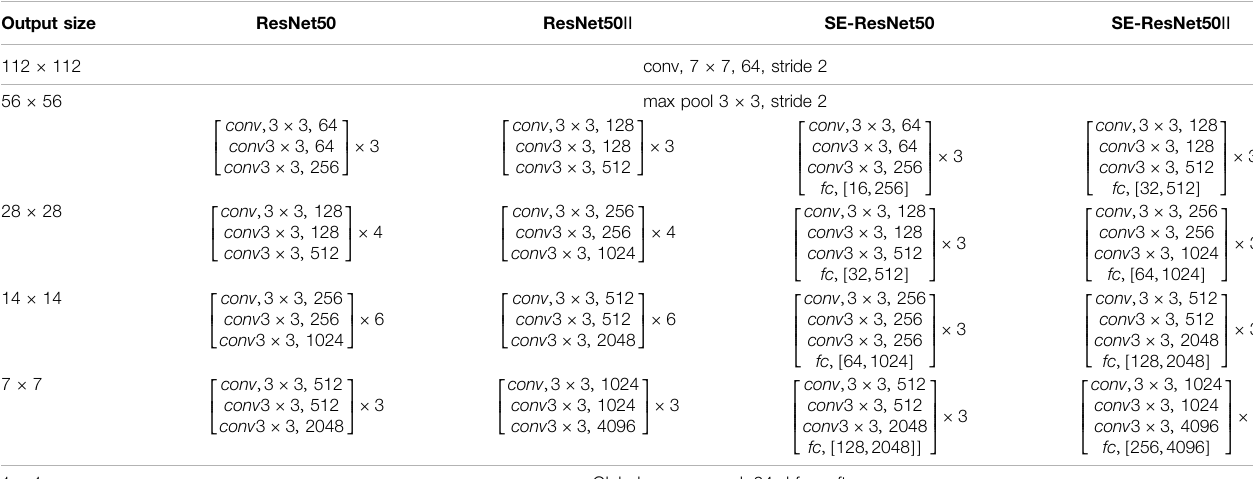
TABLE 6 | Four kinds of network architecture